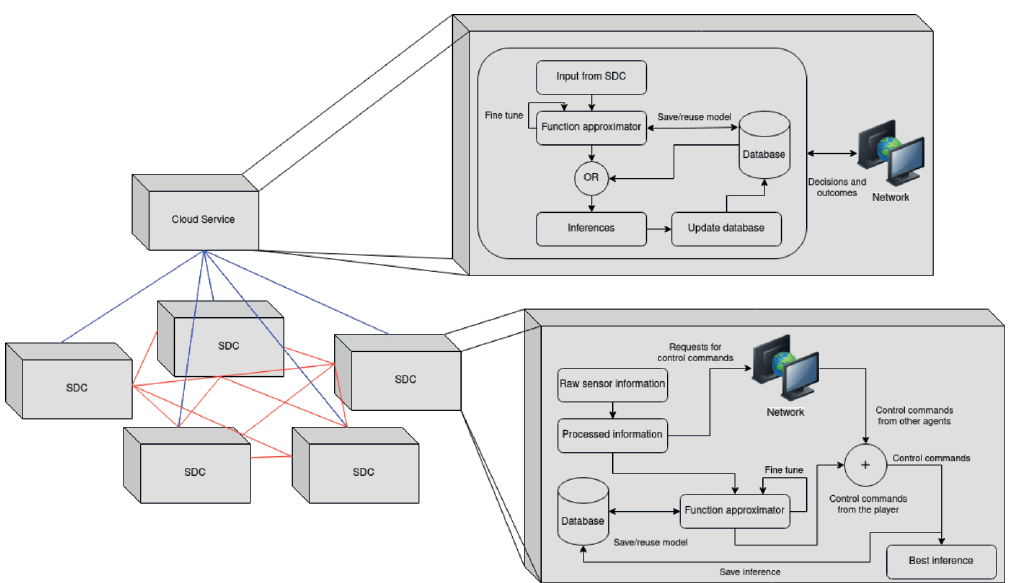
Figure 7. Centralised and decentralised structure of the knowledge sharing module (SDC: Self- Driving Car).